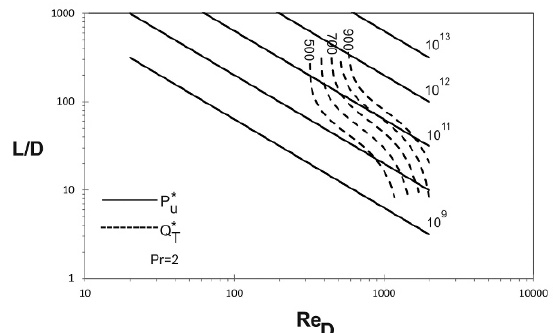
Figure 5. L/D group versus the Reynolds number for different di- mensionless heat transfer conductance and fluid pumping power (laminar regime and prescribed wall temperature boundary)